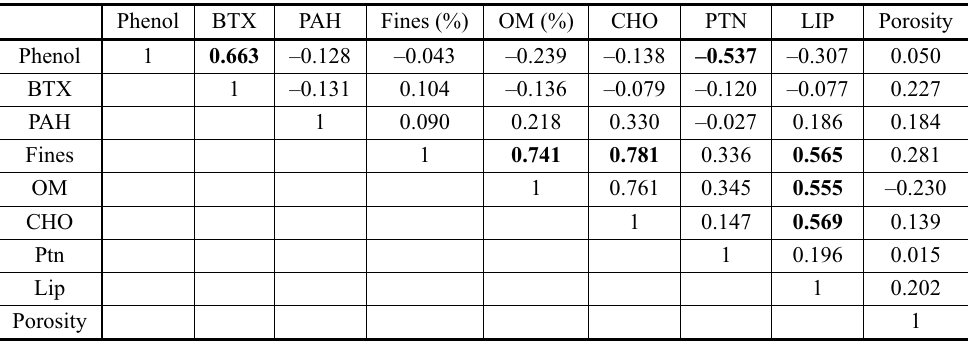
Correlation matrix of the studied